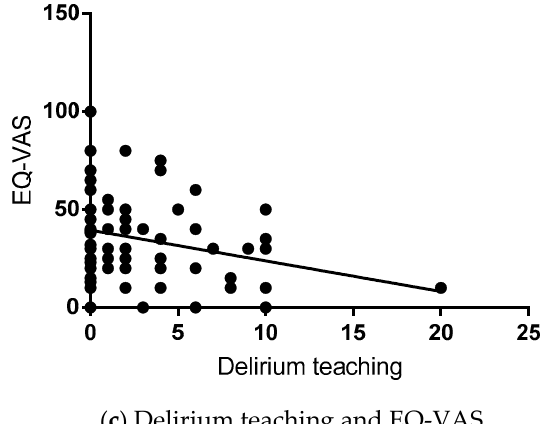
Figure 2. Relationship between physical health and the participants’ professional experiences and delirium educations. Physical health was assessed using the DSS, EQ-5D-5L, and EQ-VAS. Participants’ professional experiences were presented in years, delirium teaching refers to hours/five years period. Pearson correlation analysis was used. Statistical values ( r - and p -values) were inserted within the main body of the text.